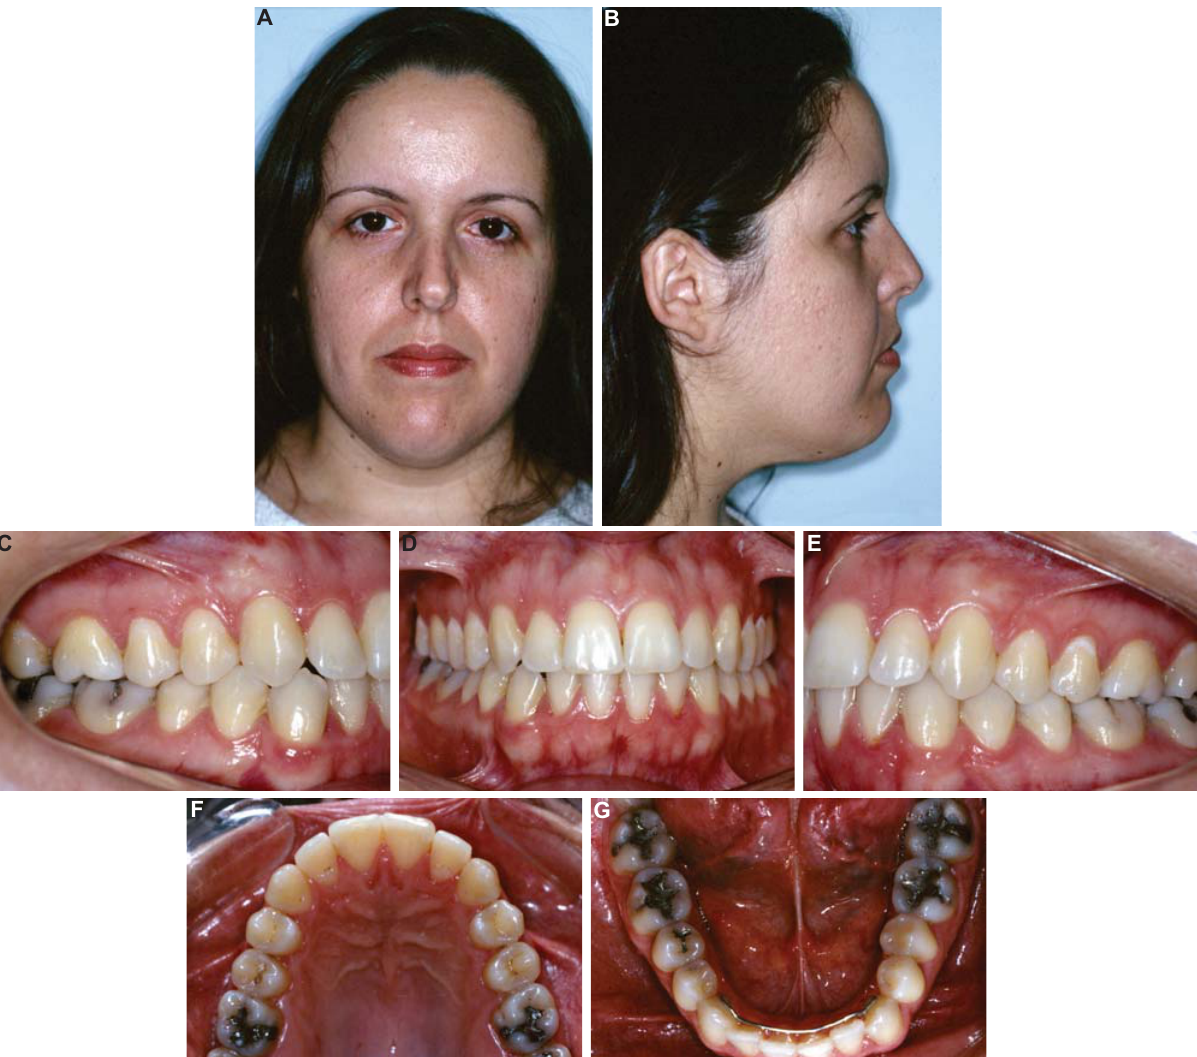
Figure 8- 14-year posttreatment extraoral (A and B) and intraoral (C-G) photographs (parents authorized the publication of these pictures)